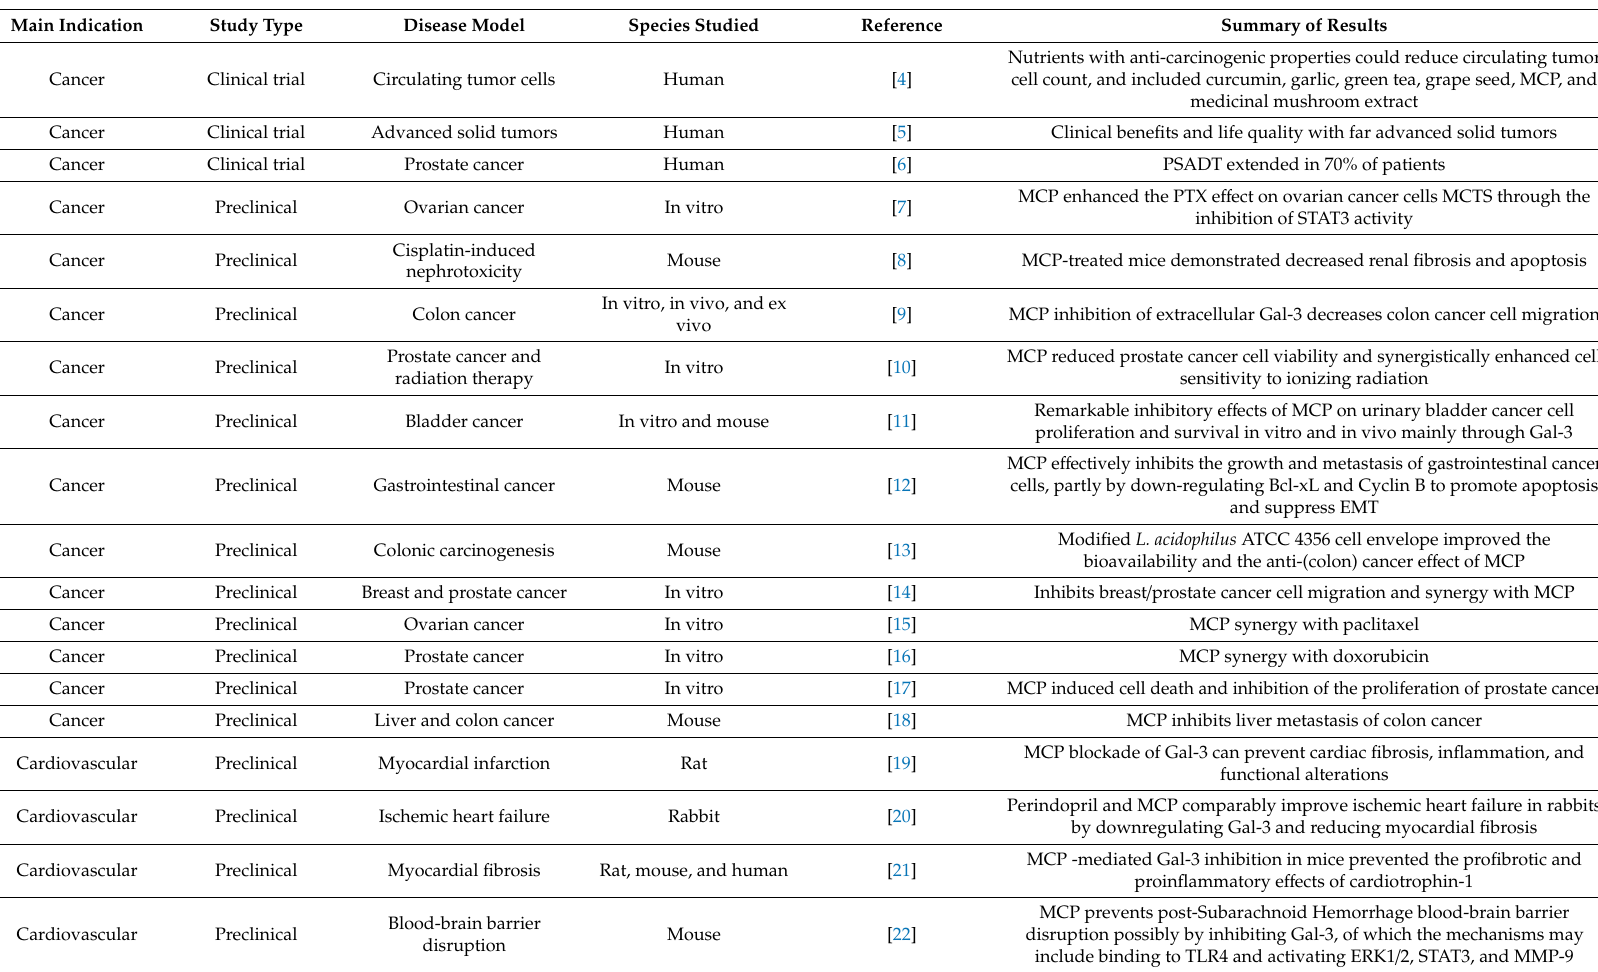
Table 1. Pleiotropic e ff ects of modified citrus